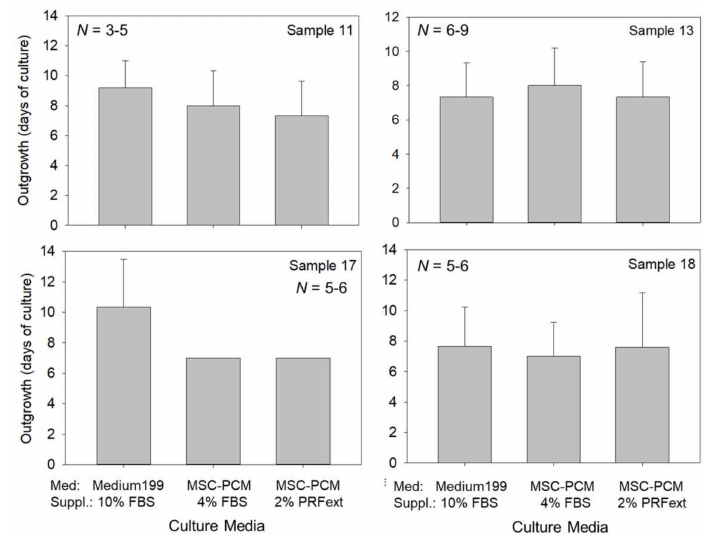
Figure 1. Effects of different culture media on the onset of periosteal cell outgrowth. The data obtained from periosteum samples derived from four independent donors are shown. X -axis: types of culture media. Statistical analysis was performed by Kruskal–Wallis one-way analysis of variance, followed by Steel–Dwass multiple comparison test. No significant difference was observed between the groups. N = 3, 4, 5, 6, or 9 replicates.